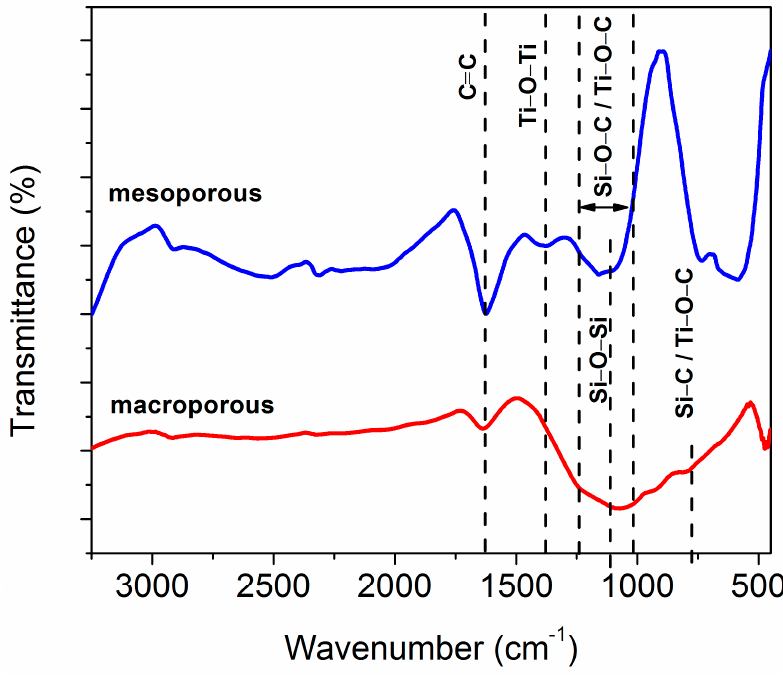
Figure 13. FTIR transmittance spectra of TiO 2 /SiOC nanocomposite indicating the bonding